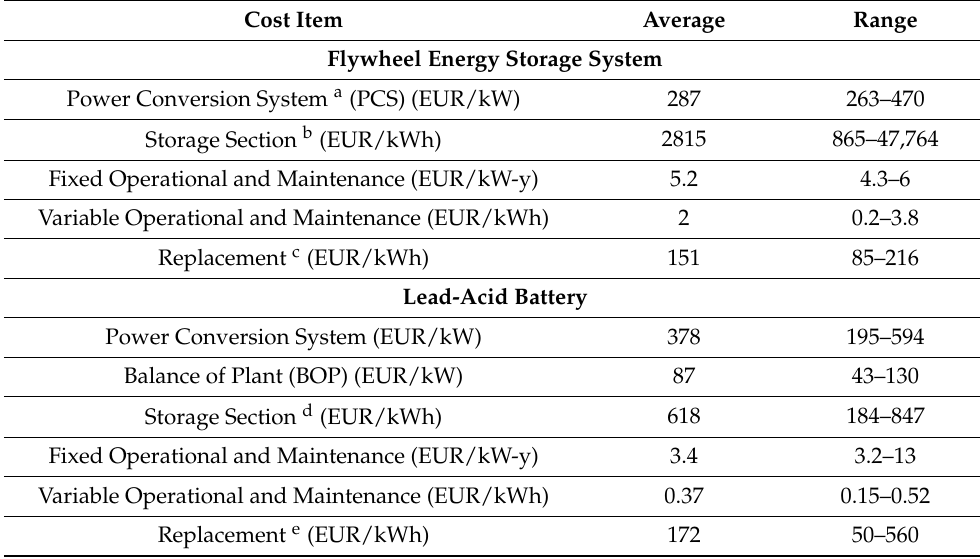
Table 4. Main cost items of FESS and lead-acid batteries [25].